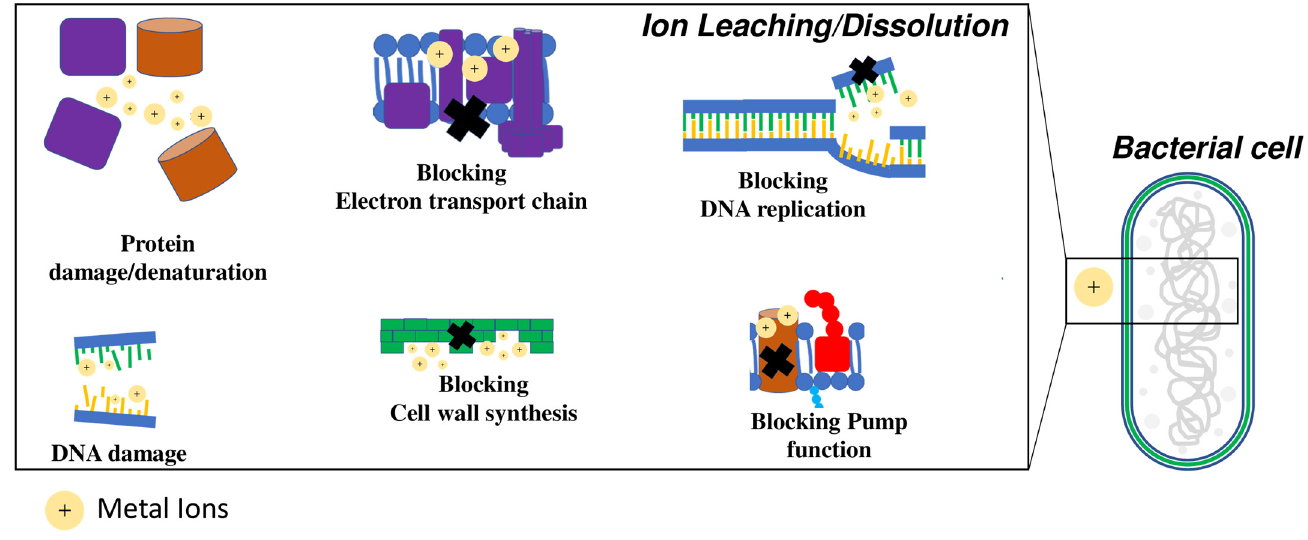
Figure 4. Schematic description and targets of antibacterial mechanisms due to the release of metal ions (+) by nanoparticles (NPs).